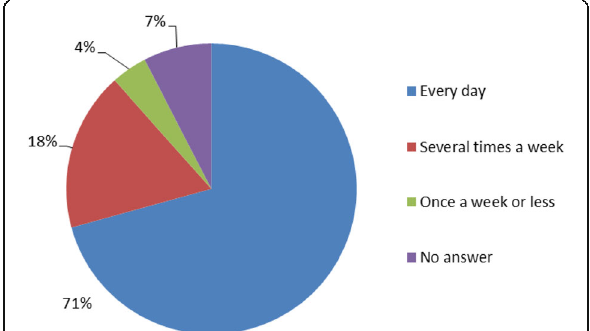
Fig. 4 The percentage division of children depending on the